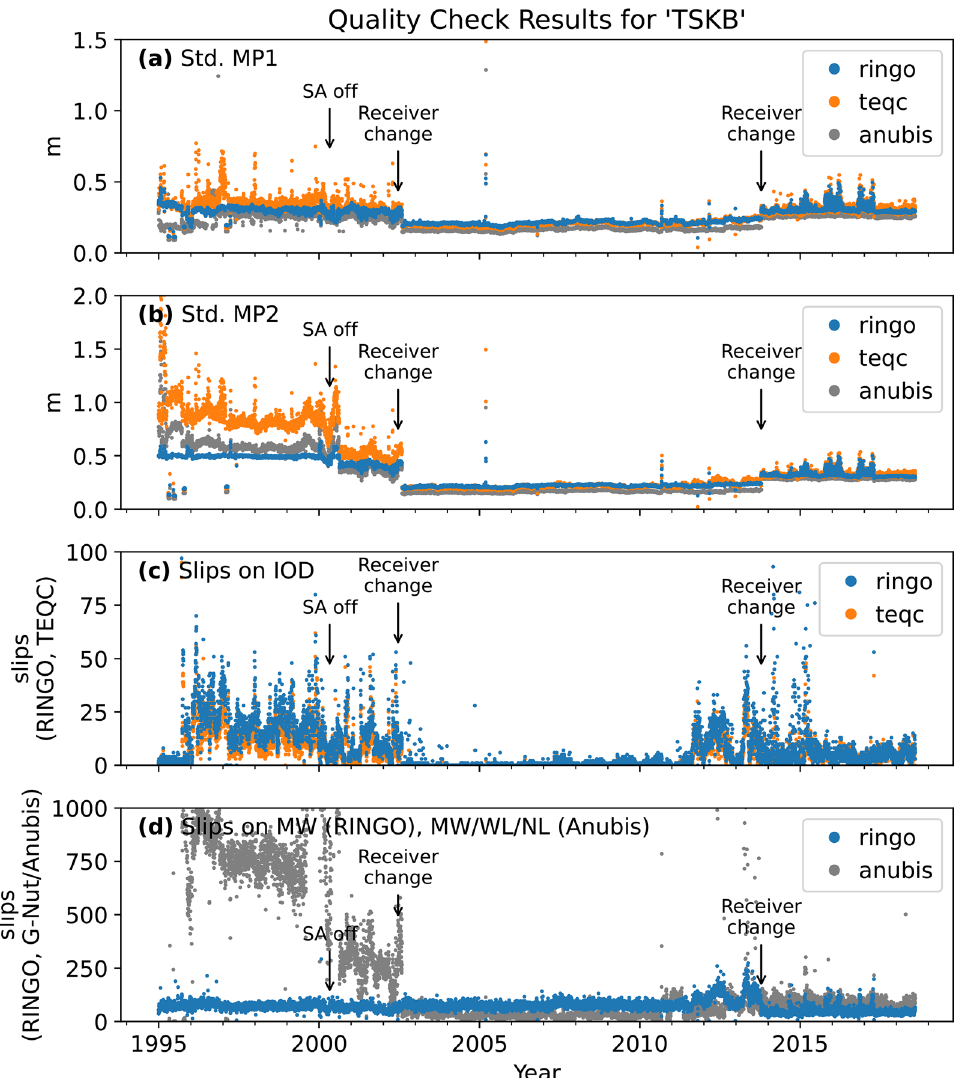
Fig. 5 Example of quality check. Standard deviations of a MP1, b MP2 linear combinations, and number of cycle slips detected from c change rate of ionosphere delay, and d Melbourne–Wübbena linear combinations. Results by RINGO (blue), TEQC (orange), and G-Nut/Anubis (gray) are